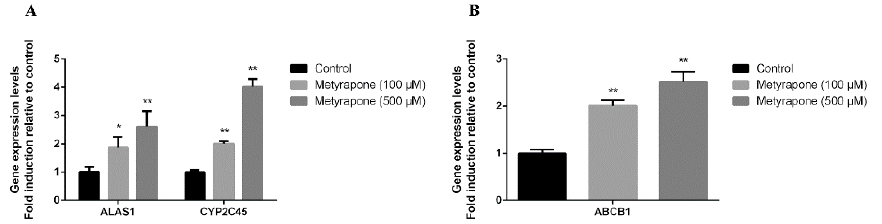
Figure 1. CXR-mediated upregulation of P-gp in primary hepatocyte cultures. Cells were exposed to various concentrations of the CXR agonist metyrapone for 24 h. RT-PCR analysis of ALAS1, CYP2C45 ( A ) and ABCB1 ( B ) mRNA levels. Bars show means ± SD of at least three independent experiments. * p < 0.05, compared with the control group; ** p < 0.01, compared with the control group.